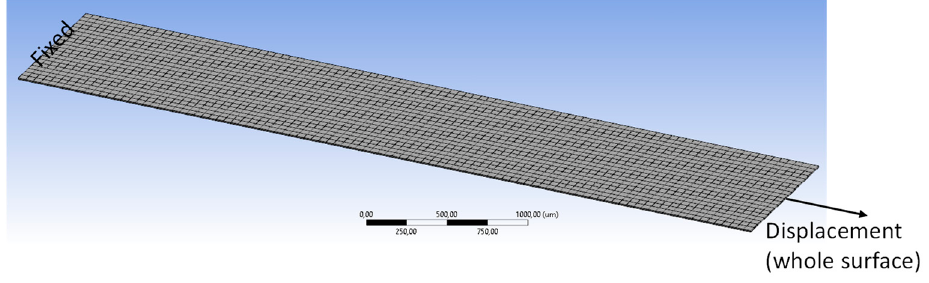
Figure 7. FEM model and its boundary conditions.